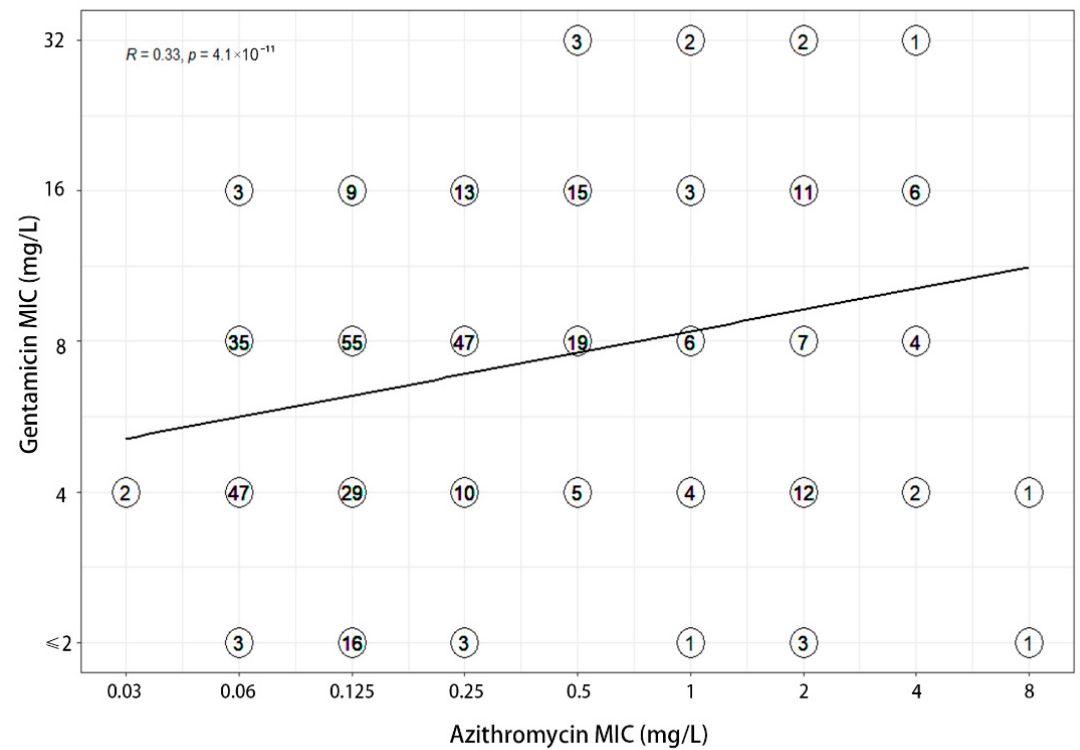
Figure 1. Correlation between MICs to gentamicin and azithromycin. Each symbol with a number signifies one or more isolates. Before computing the regression line, the MIC values were log transformed (log 2 ).